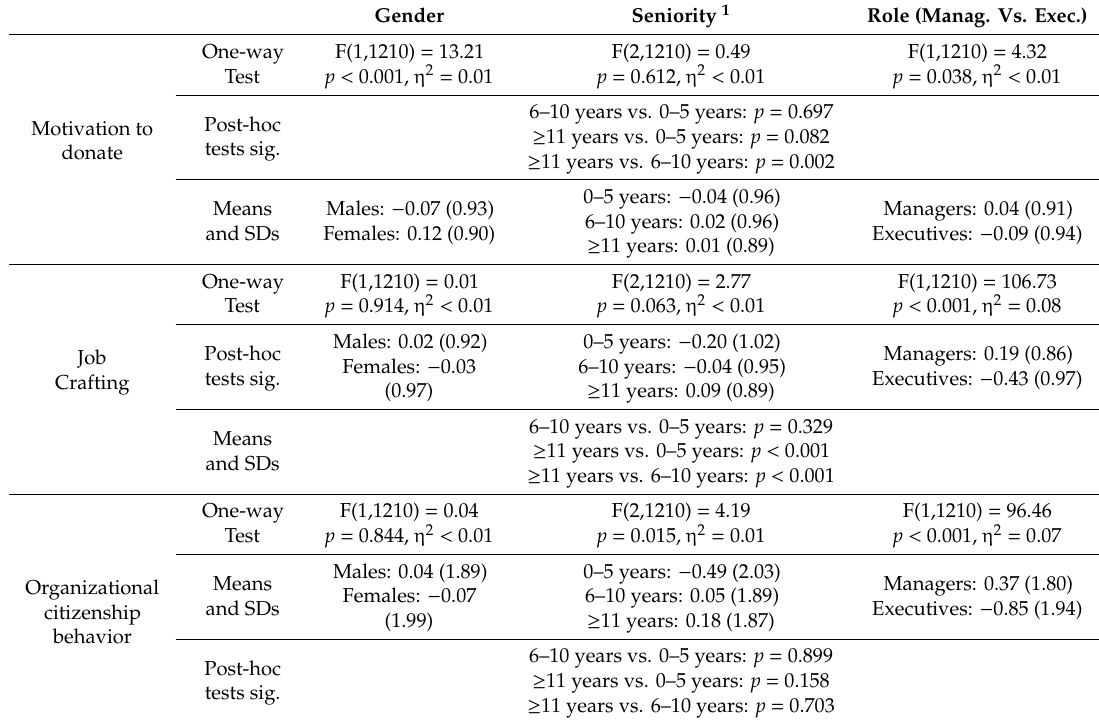
Table 3. Influence of the variables Gender, Seniority, and Member’s role on the construct scores. Seniority 1 Role (Manag. Vs.